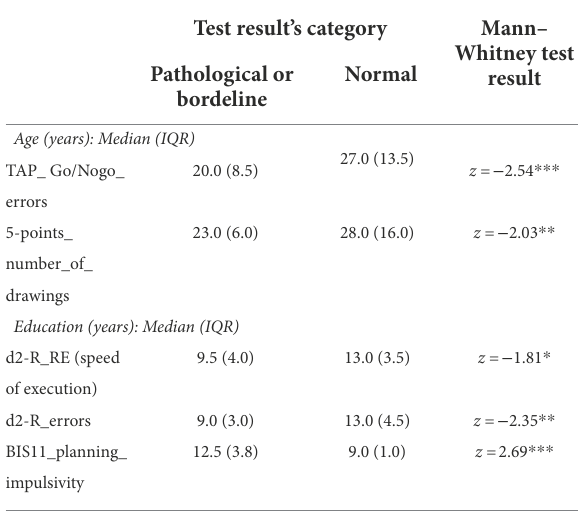
TABLE 2 Results of the bivariate analysis. Test result’s